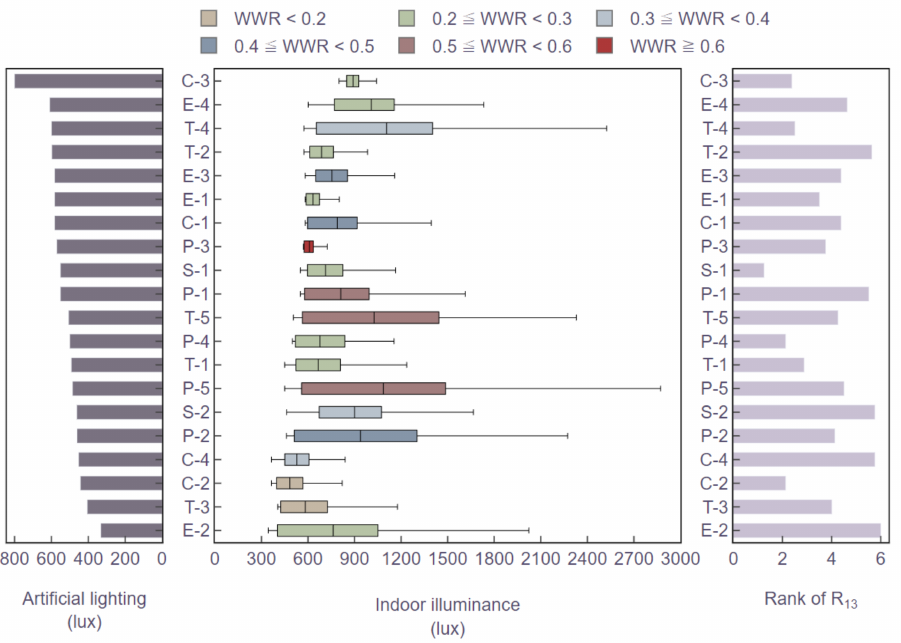
Figure 9. Analysis results of indoor illumination for the investigated